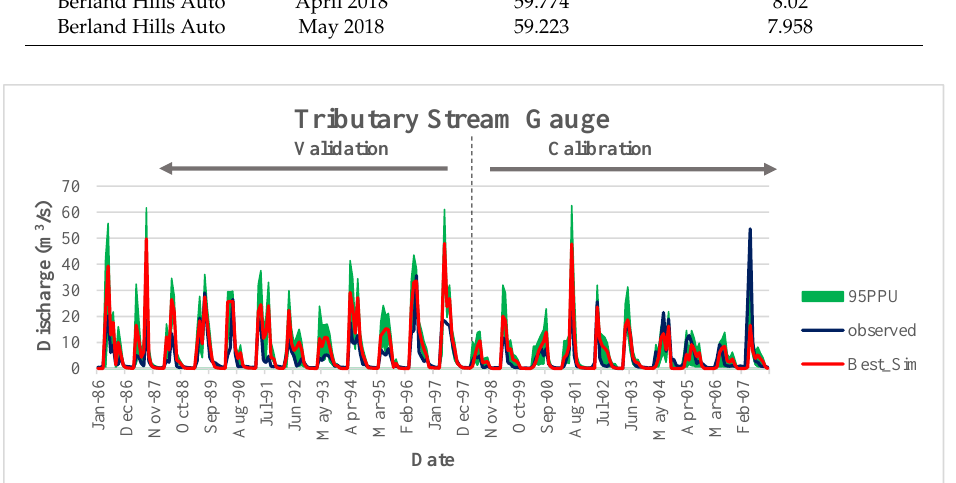
Figure A2. Calibration and validation results for the Little Smoky River watershed tributary gauge.